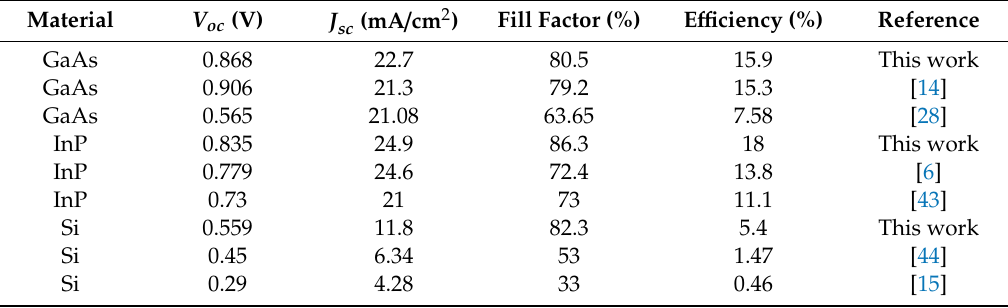
Figure 6. ( a ) The schematic diagram of the IBRE-NWA structure. ( b ) 3-D total optical generation profiles in the BRE-NWA and IBRE-NWA structures. ( c ) Conversion efficiency comparison of NWA, BRE-NWA, and IBRE-NWA structures. Table 1. Photovoltaic performance of reported p-i-n junction NWA solar cells.